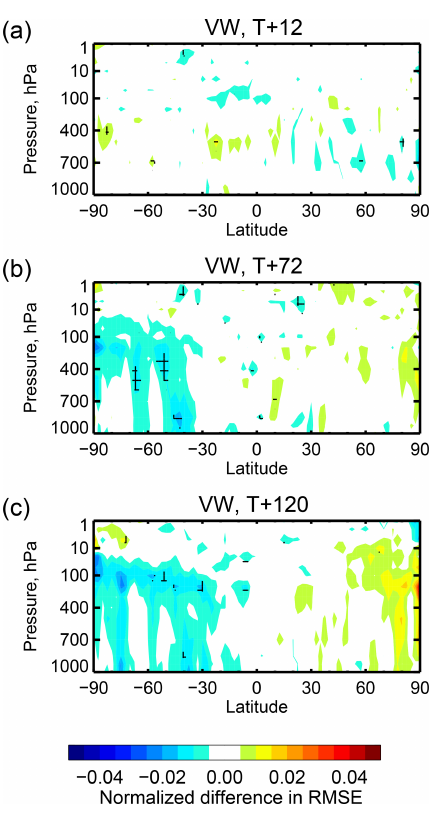
Figure 13. Normalized change in vector wind RMSE due to assimi- lation of the seven IASI WV channels using the clear-sky approach, as for Fig.